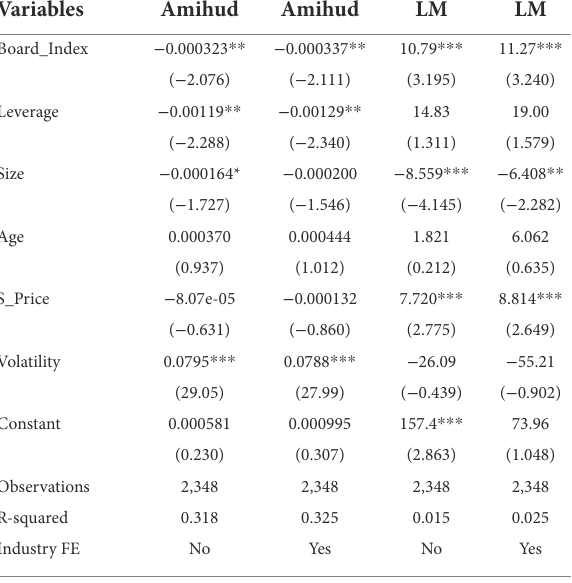
TABLE 4 Board index and stock liquidity (OLS Regression).